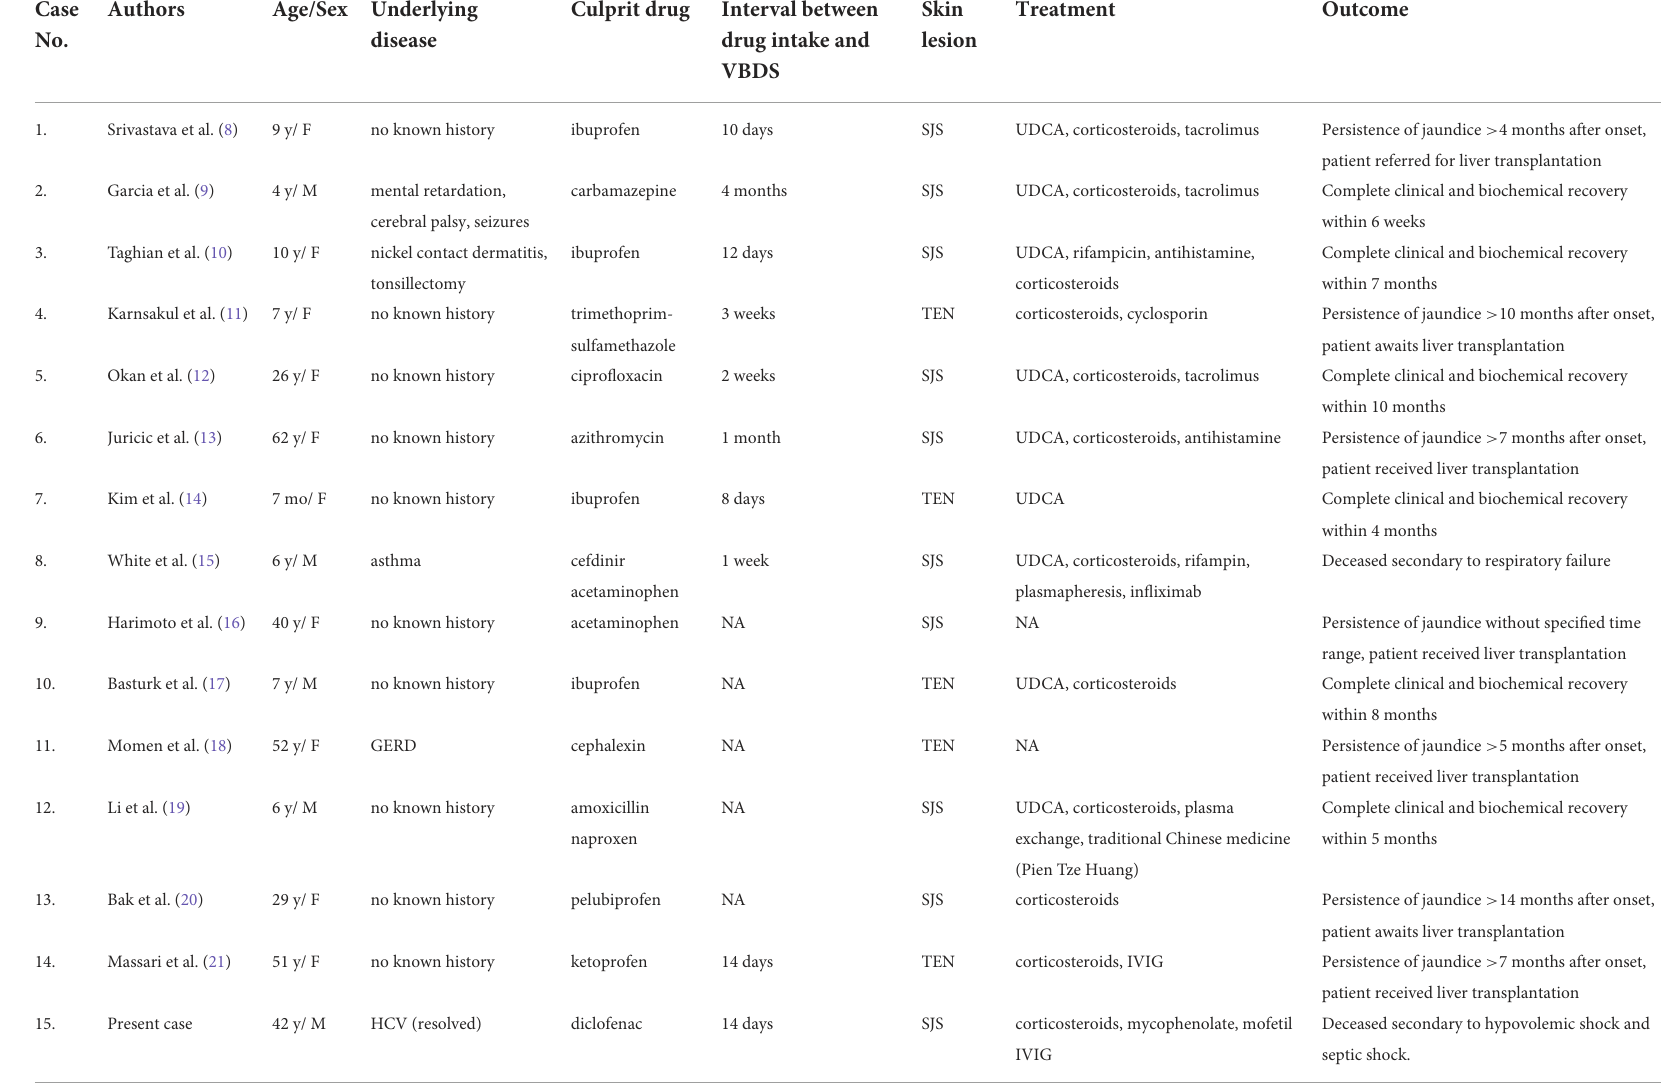
TABLE 1 Drug-induced Vanishing Bile Duct Syndrome (VBDS) associated with Stevens-Johnson Syndrome (SJS) or Toxic Epidermal Necrolysis (TEN).